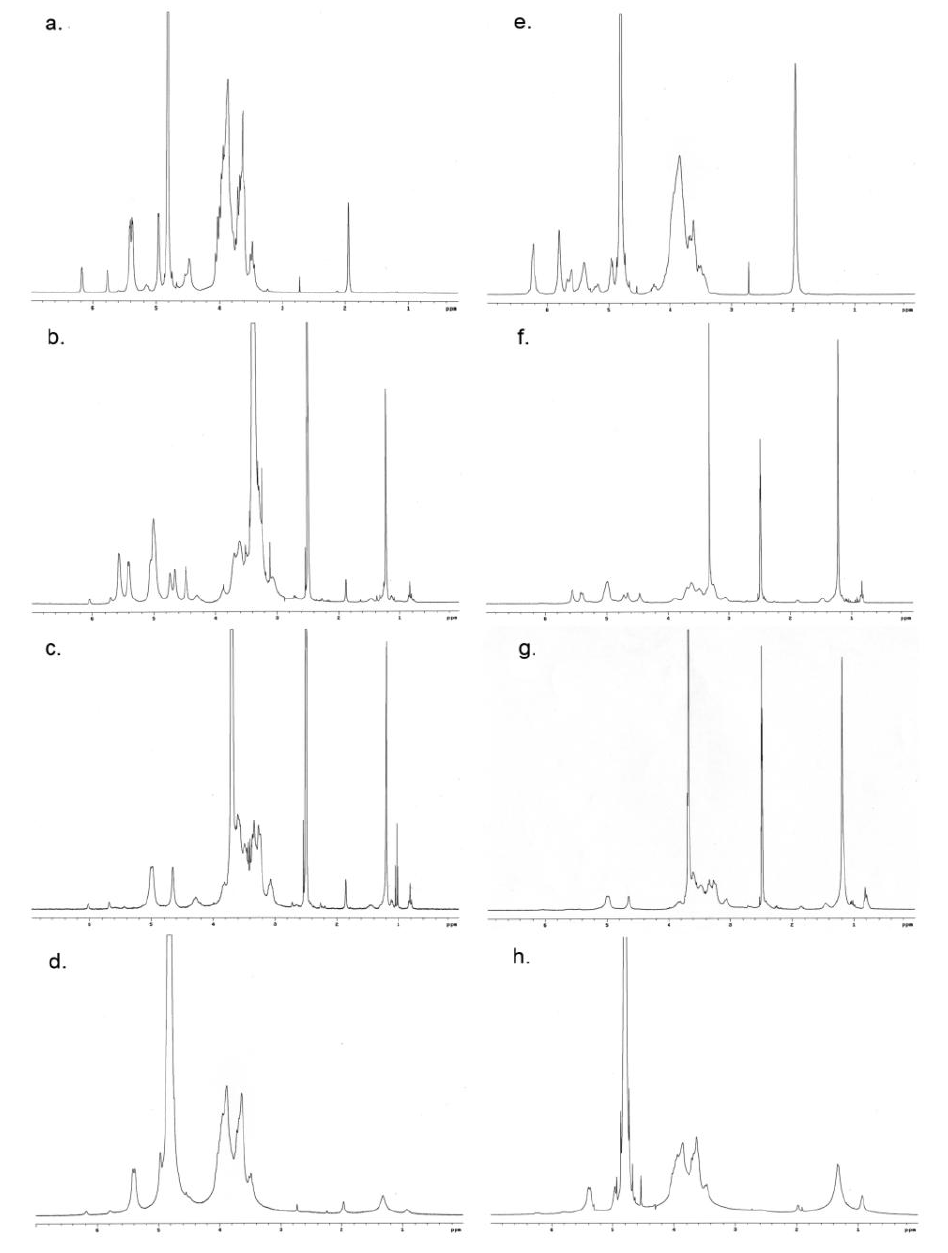
Figure 1. 1 H NMR spectra of ( a ) pullulan-HEMA and ( e ) pullulan-VMA in D spectra of PHC -5.6-1.3 and PVC 16 and ( d , h ) D O, 2